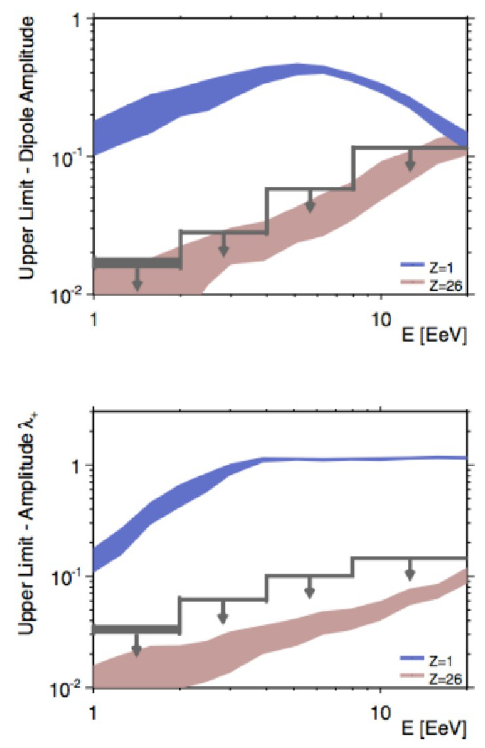
Figure 8: 99% CL upper limits on the dipole and quadrupole momenta as a function of